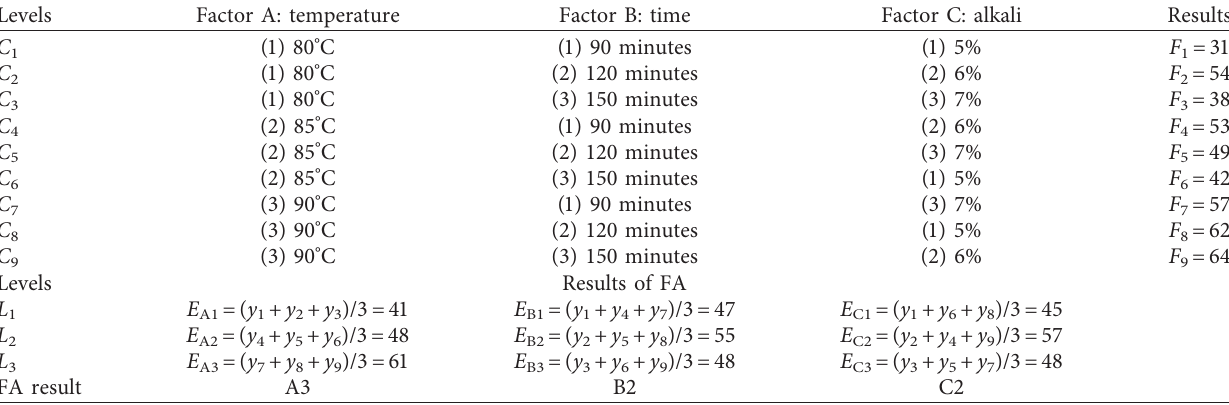
Table 2: Result of factor analysis.